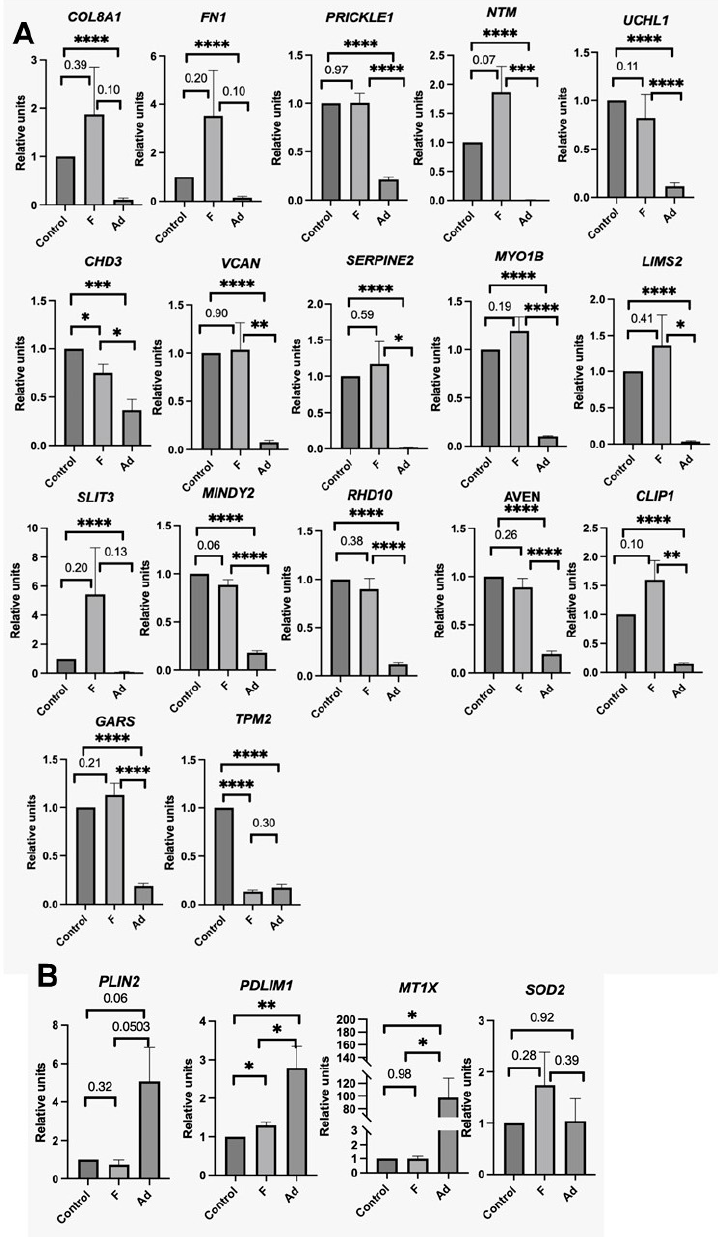
Figure 3. Change in gene expression evaluated by RT-PCR. The data are presented as the ratio of the level of gene expression to the control, mean ± SE, * p < 0.05, ** p < 0.01, *** p < 0.001, **** p < 0.0001, at p > 0.05 indicates p value. ( A ) Genes whose expression increased upon differentiation into myofibroblasts and decreased upon induction of adipogenesis according to transcriptome analysis, ( B ) Genes whose expression decreased upon differentiation into myofibroblasts and increased upon the induction of adipogenesis, according to transcriptome analysis.